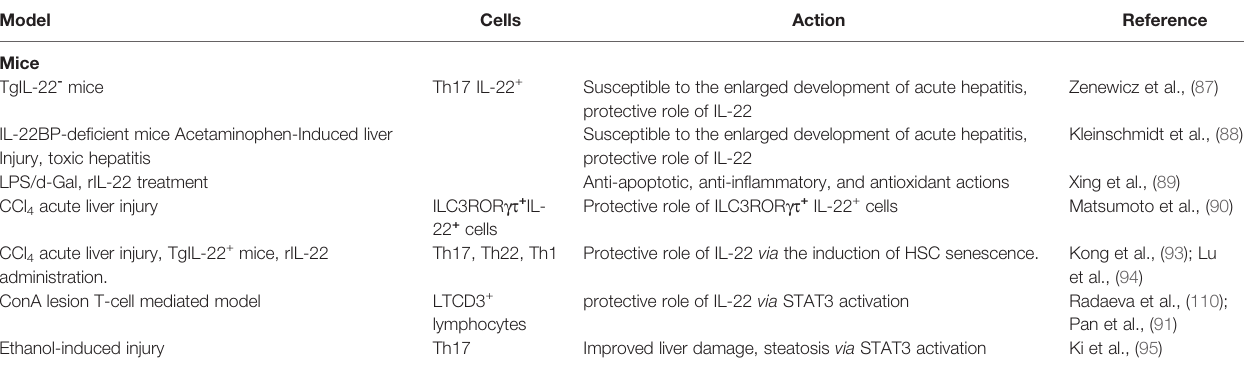
TABLE 3 | IL-22 in acute liver